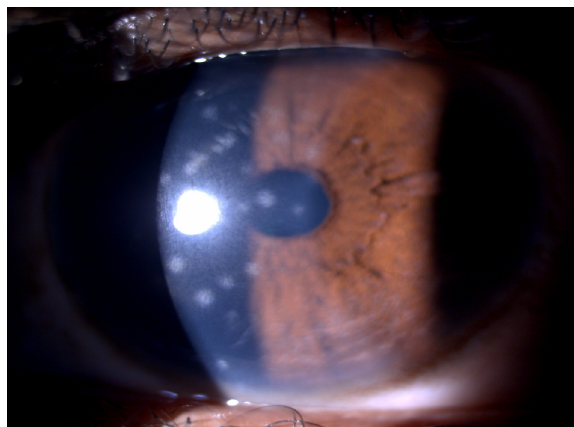
Figure 4: Slit-lamp photo showing circular subepithelial infiltrates in the right